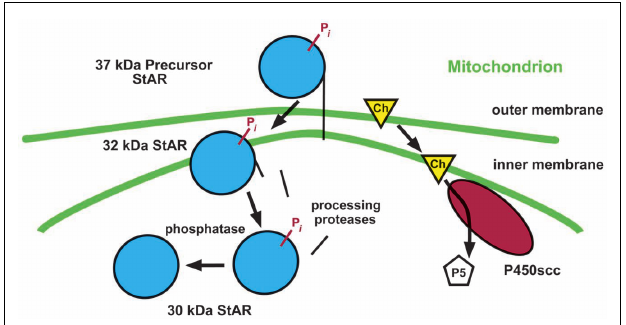
FIGURE 1 | Mechanism of StAR action. Following synthesis and an activating phosphorylation (P i ), StAR catalyzes the movement of cholesterol (Ch) in the outer mitochondrial membrane to the inner membrane through an unknown mechanism.There, cytochrome P450scc converts cholesterol to the steroid pregnenolone (P 5 ), using reducing equivalents supplied by adrenodoxin reductase via adrenodoxin (not depicted). StAR is then imported into the mitochondria and processed to smaller